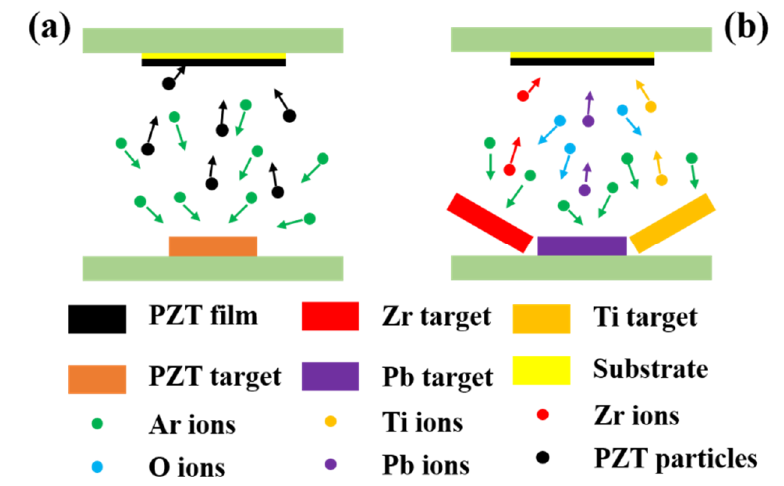
Figure 2. Schematic diagram of ( a ) RF sputtering and ( b ) DC reactive sputtering. RF sputtering usually employs ceramic targets while DC reactive sputtering often applies to metal targets.